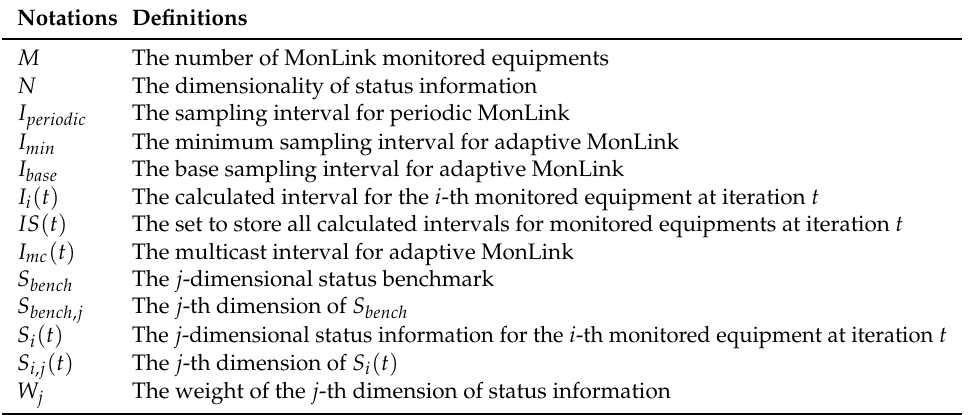
Table 1. Notations and definitions for adaptive